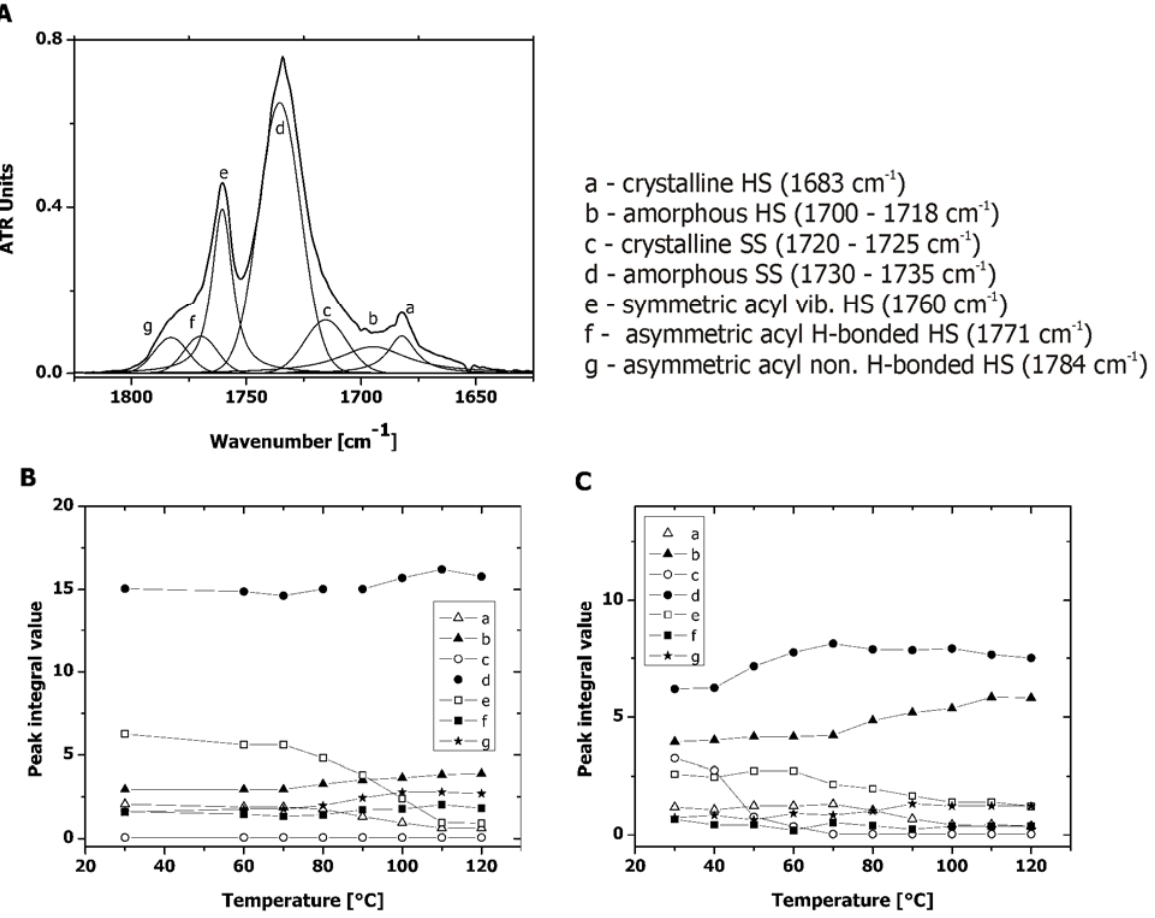
Figure 6. Carbonyl region of PAUs (transmission Fourier Transform Infra Red (FTIR)) prior to degradation. ( a ) Assignment of peaks of the PAU1000 carbonyl region curve fit; ( b ) PAU1000–integral values of peaks with temperature increase; ( c ) PAU15000–integral values of peaks with temperature